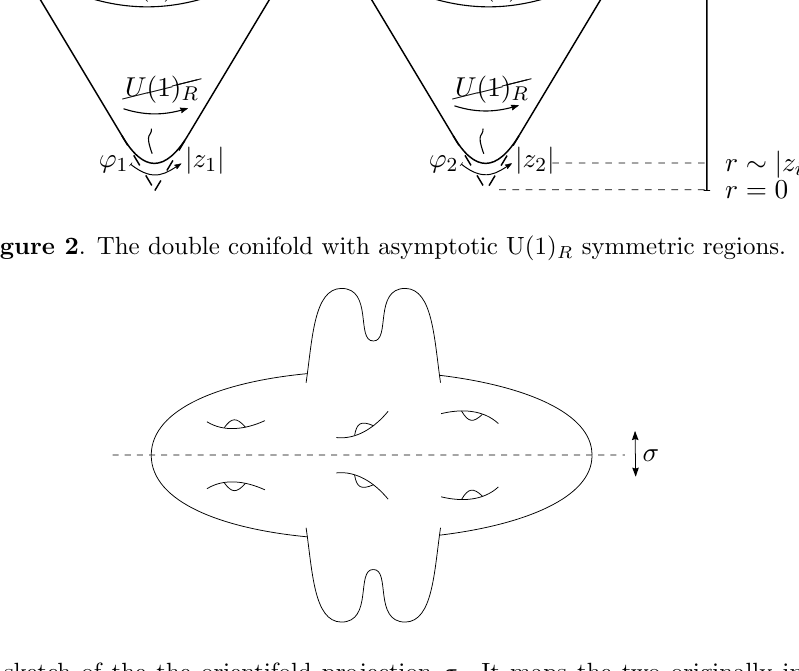
Figure 3 . A sketch of the the orientifold projection (cid:27) . It maps the two originally independent double throat cycles B and B 0 onto one